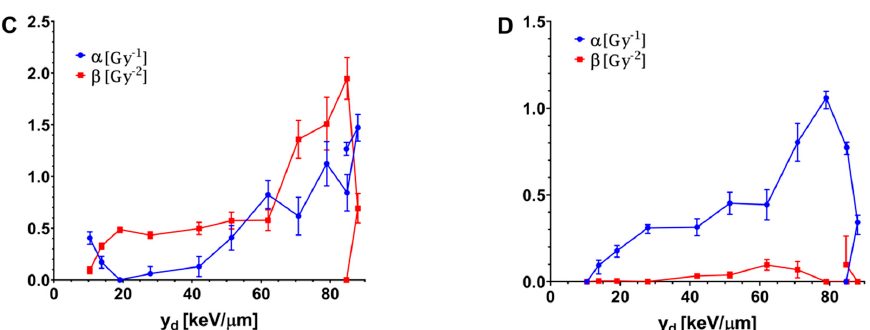
Figure 2. Clonogenic survival results for two non-small cell lung cancer cell lines exposed to helium ions. ( A ) The H460 and ( B ) H1437 cell line results from helium ion irradiations performed at the Heidelberg Ion Therapy Center. A high-throughput irradiation jig was developed to sample locations along a 84 MeV/u helium ion beam. For both cell lines, clonality was found to be increasingly reduced with increasing helium ion y d until 84.9 keV/ μ m for the H460 line and 79.0 keV/ μ m for the H1437 line. to increase, indicating a reduced biological effect. Error bars are SEM. ( C ) α (blue) and β (red) values